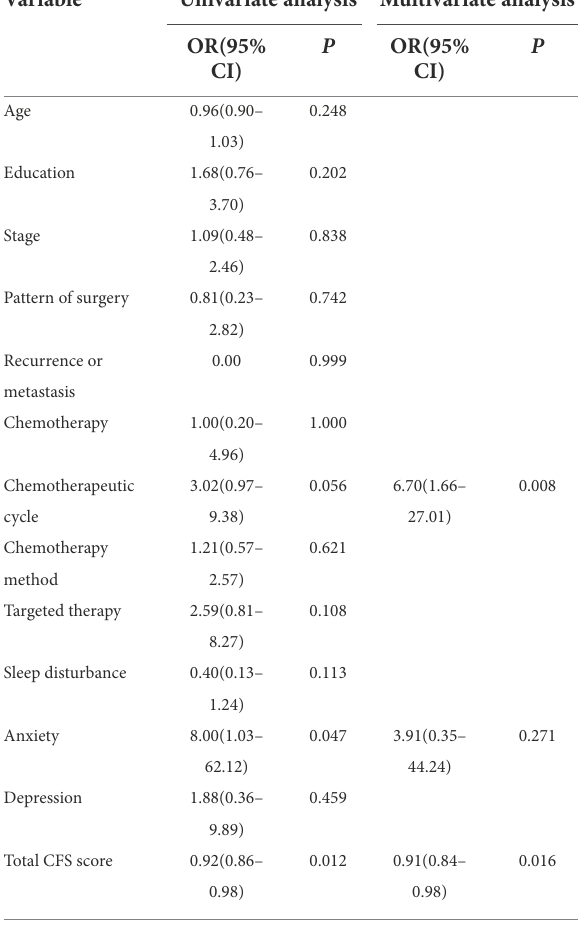
TABLE 4 The predictors of need for psychological counseling in breast cancer patients during COVID-19 pandemic. Variable Univariate analysis Multivariate